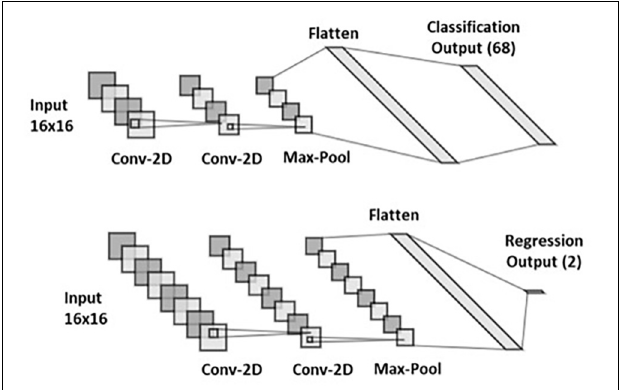
FIGURE 6 | UVC-based convolutional neural networks (CNNs). Structure of 68-feature classification (top) and 2-output regression (bottom).